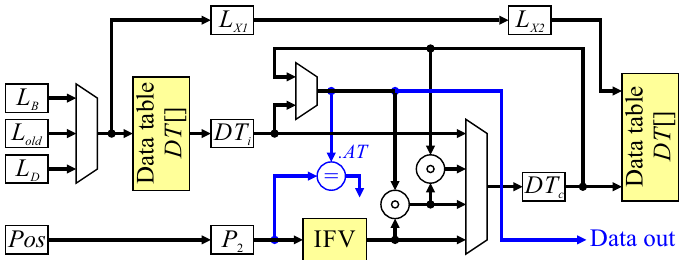
Figure 12. Architecture for data table update. Blue signals relate to detecting completed